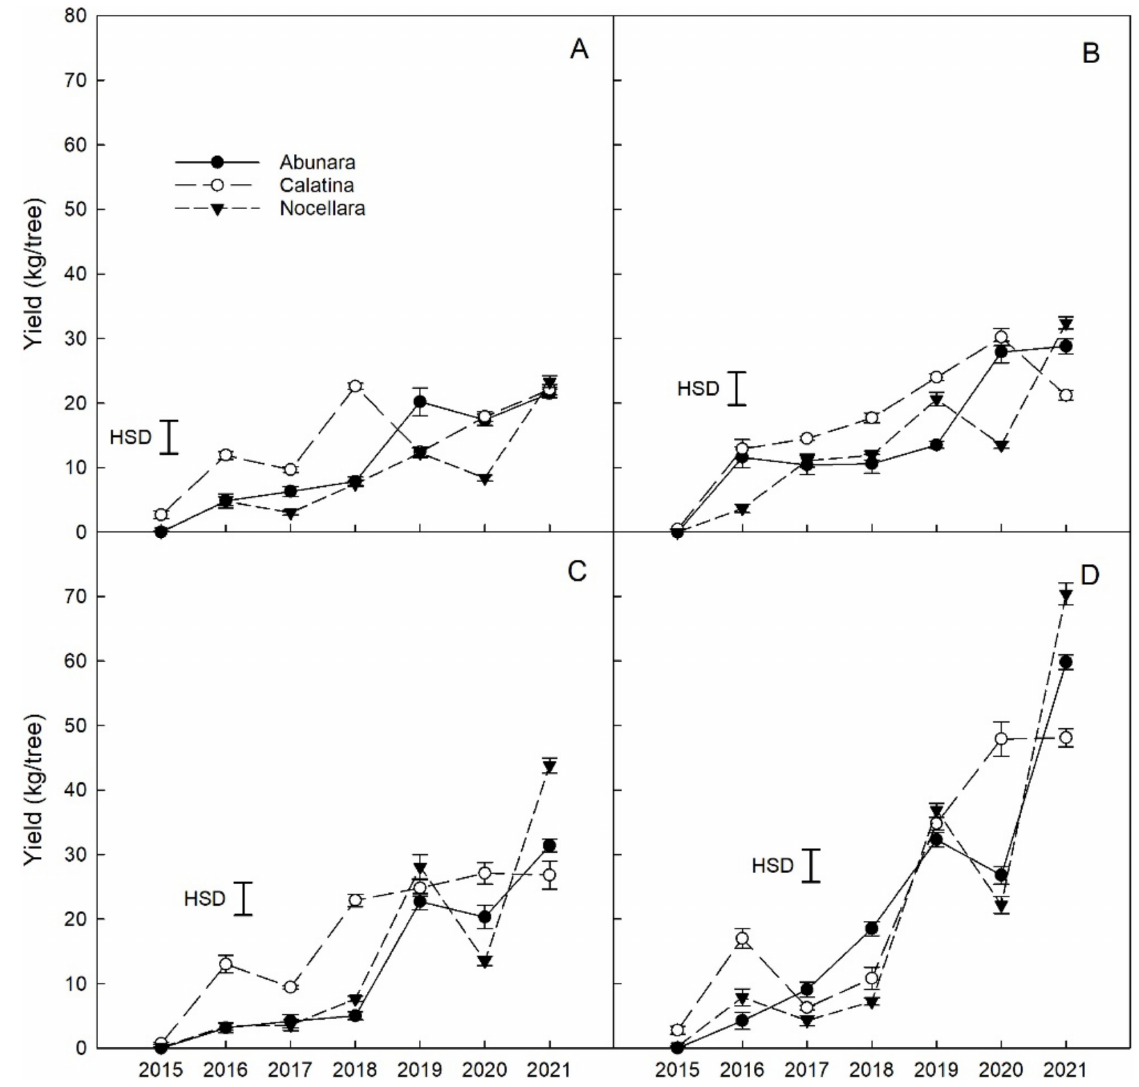
Figure 3. Trends of fruit yield per tree across the seven years of trial for ‘Abunara’, ‘Calatina’, and ‘Nocellara del Belice’ olive trees grown as central leaders at 2 × 5 m (CLx2, ( A )), free palmette at 3 × 5 m (FPx3, ( B )), globe vase at 4 × 5 m (GVx4, ( C )), and polyconic vase at 5 × 5 m (PVx5, ( D )). Error bars represent standard errors of the means. Mean separation by Tukey’s honestly significant difference (HSD, p <